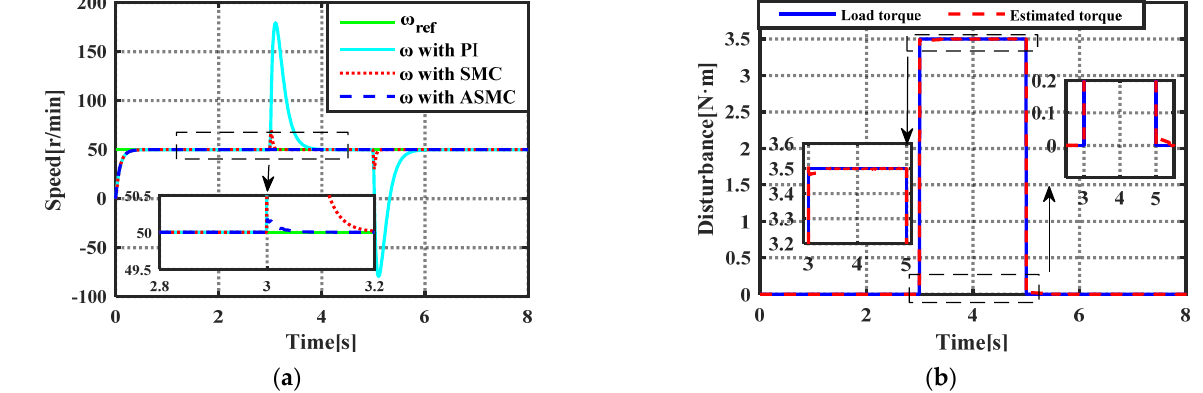
Figure 6. Simulation results of disturbance rejection with external load. ( a ) The speed tracking performance with three control methods; ( b ) the estimated load torque and the load torque.